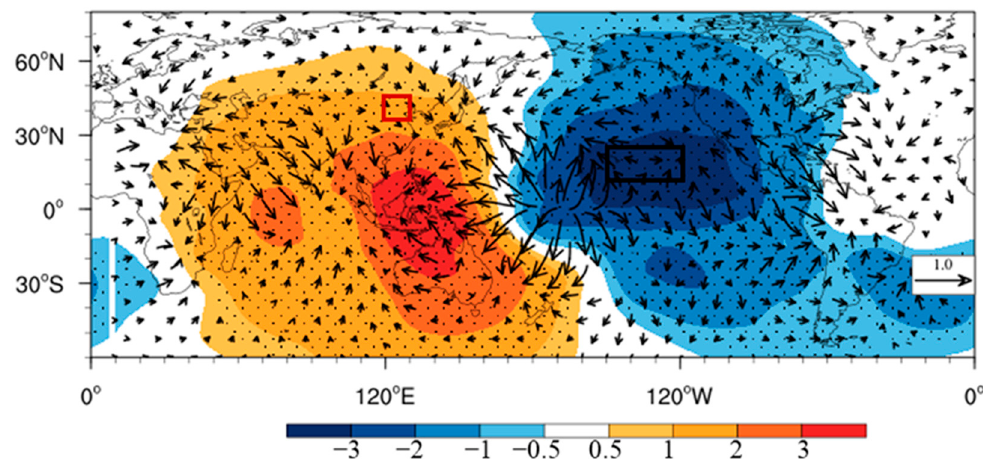
Figure 8. Regressed DJF global 200-hPa velocity potential (shading; m 2 s − 1 ) and divergent flow (vector; m s − 1 ) onto Northeast Pacific SST anomalies in July from the observation. Stippling indicates significant regressed velocity potential anomalies at the 95% level from Student’s t -test. Black vectors are significantly regressed 200-hPa divergent wind anomalies at the 95% level from Student’s t -test.